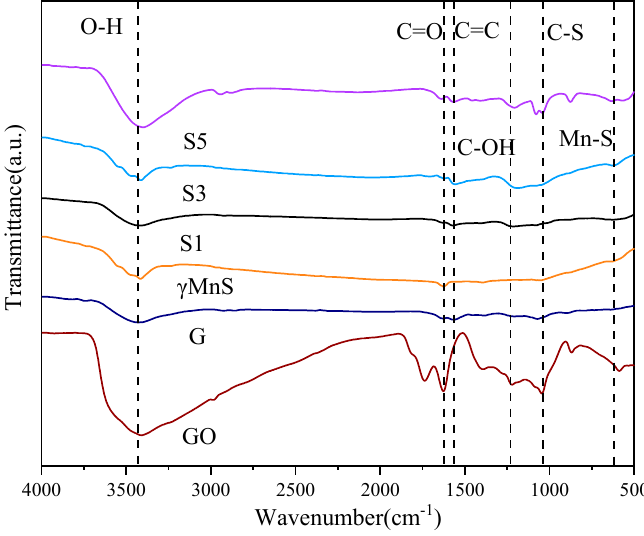
Figure 5. FTIR spectra of NCs, γ MnS, graphene and GO.